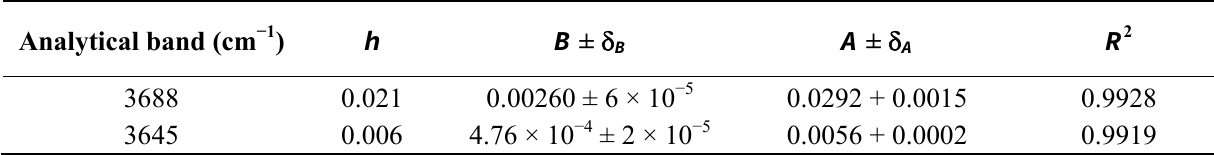
Table 2. MoA curve